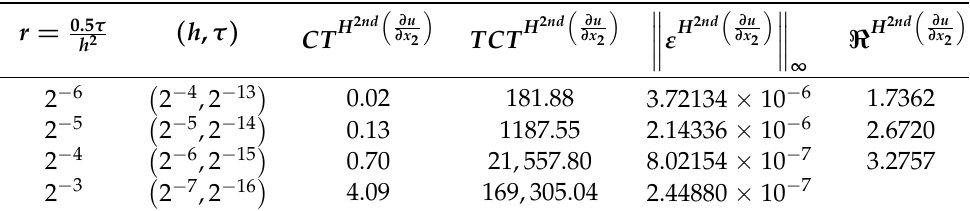
≤ 3 when r = 0.5 τ . 7 ∂ x 2 h 2